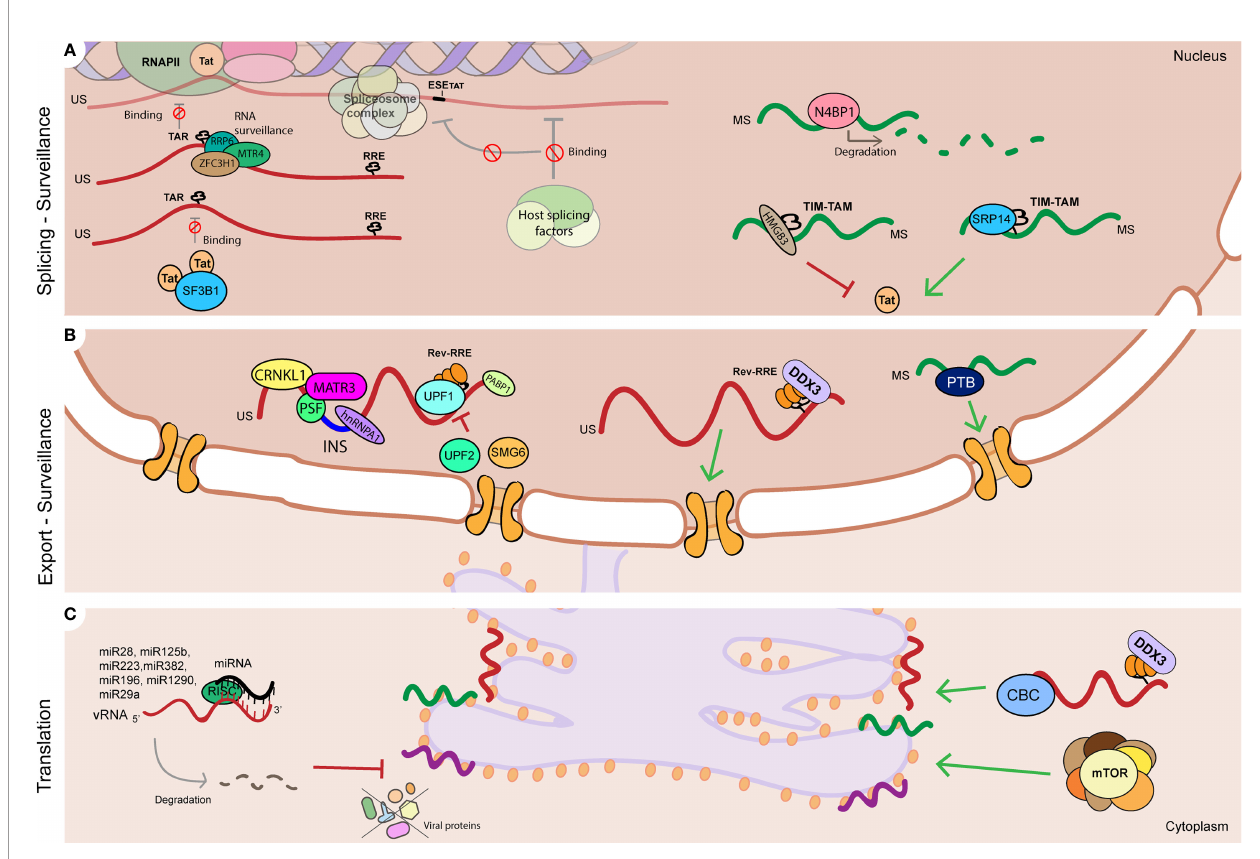
FIGURE 2 | RNA processing mechanisms linked to HIV-1 latency. (A) Regulation of HIV-1 vRNA splicing is involved in HIV-1 latency by multiple mechanisms such as: Tat protein levels and activity at the HIV-1 LTR TAR can be controlled by regulating Tat-containing mRNA splicing (ESE-Tat), and action of host factors that prevent Tat-TAR interaction by binding to TAR (SF3B1), and positively (SRP14) or negatively (HMGB3) regulate Tat mRNA processing and translation by binding to TIM-TAM RNA element. Viral RNA processing is also controlled by surveillance mechanisms that prevent Tat-TAR binding in the US vRNA (RRP6, MTR4, ZFC3H1), promote degradation of MS vRNA (N4BP1), and (B) regulate US vRNA stability (UPF1, UPF2 and SMG6). (B) Nucleocytoplasmic export of HIV-1 vRNA species is tightly regulated during latency: nuclear retention of US vRNA species is promoted by host proteins CRNKL1, MATR3 and PSF, and by binding of host proteins to instability sequences (INS) such as PSF, hnRNPA1 and PABP1. On the contrary, protein DDX3 and PTB positively regulate US vRNA and MS vRNA export respectively, and their absence leads to vRNA nuclear retention. (C) Modulation of viral protein synthesis can contribute to HIV-1 latency via: regulation of mTOR complex, DDX3 and CBC complex, and by microRNAs that directly target HIV-1 vRNA and lead to its degradation (miR28, miR125b, miR223, miR383, mimR196, miR1290, miR29a). RNA (vRNA) is represented as a red curved line. Single spliced (SS) 4kb viral RNA is represented as a purple curved line. Multiple spliced (MS) 2kb viral RNA is represented as a green curved line. Red fl at-head arrows represent mechanisms reported in literature to promote HIV-1 latency. Green triangle-head arrows represent mechanisms reported in literature to prevent HIV-1 latency. TAR stands for trans-activating response element. RRE stands for Rev response element. INS stands for instability sequence. Red sign ∅ represents